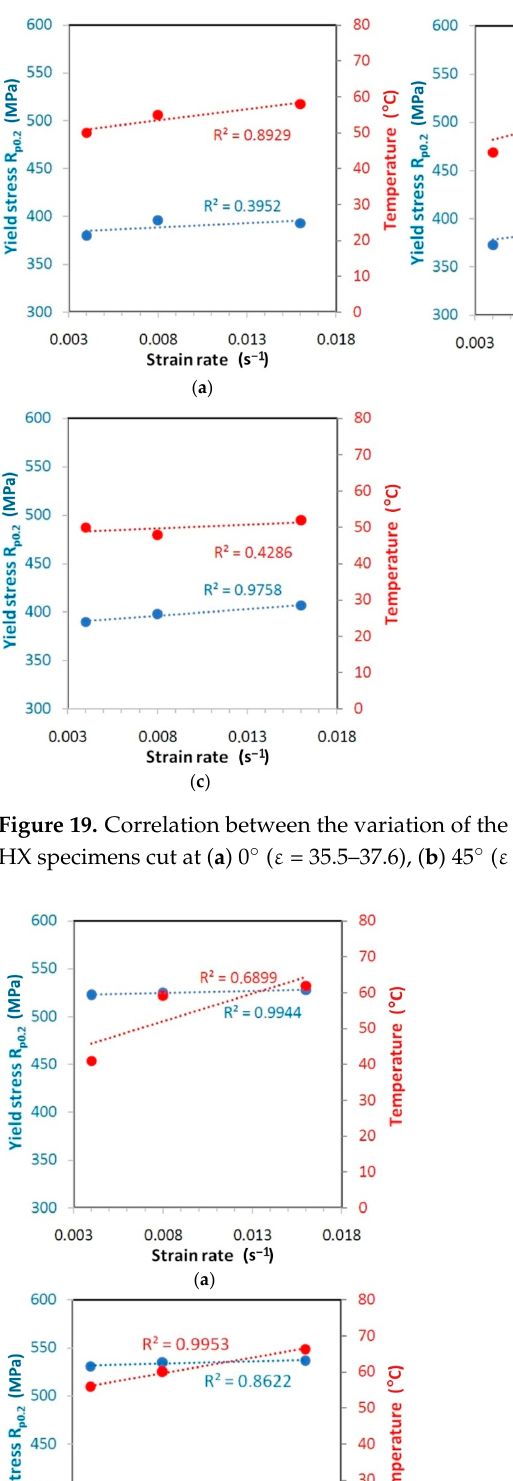
Figure 18. Yield stress vs. strain rate for ( a ) HX, ( b ) I625 and ( c ) I718. The correlations between the variation of the yield stress and measured temperature for the test materials is shown in Figures 19–21.